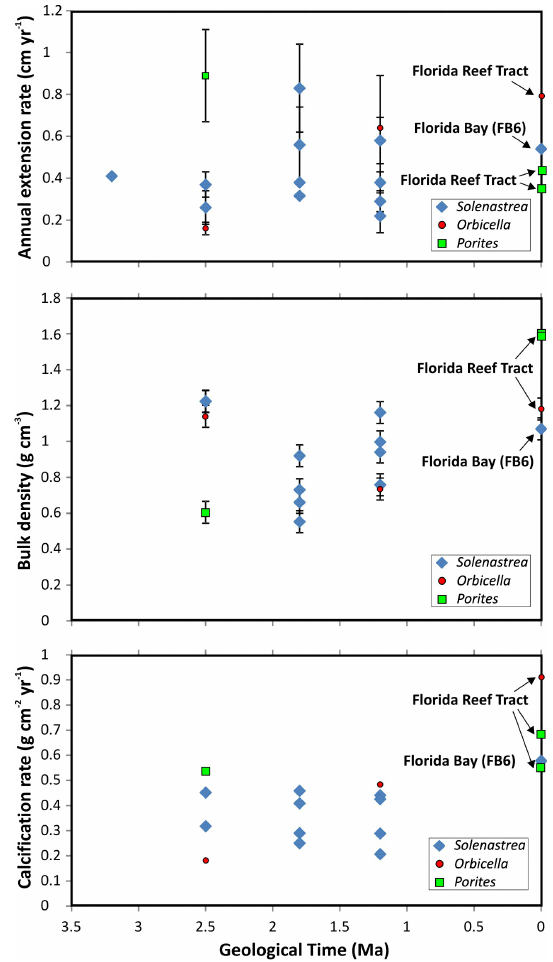
Figure 5. Temporal variation of the mean extension rate ( ± 1 σ) , bulk density and mean calcification rate in three z coral gen- era ( Solenastrea , Orbicella , Porites ) from the Pliocene–Pleistocene Florida platform. Recent data from (Helmle et al., 2011; Hudson et al., 1989; Manzello et al., 2015a; Swart et al., 1996) and own materials (Florida